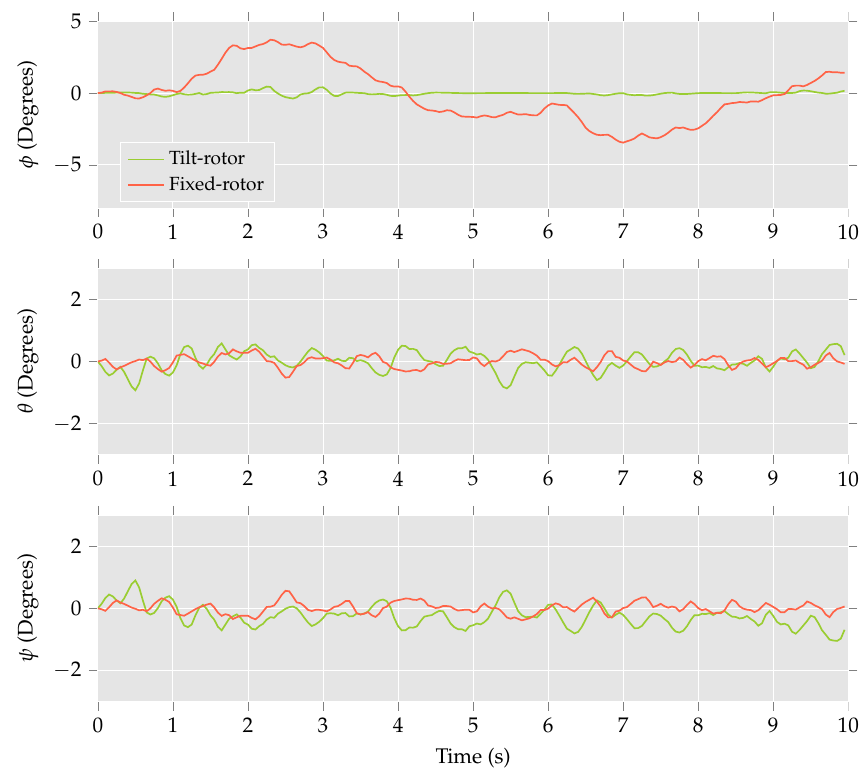
Figure 10. Multirotor helicopter attitude throughout the first maneuver.